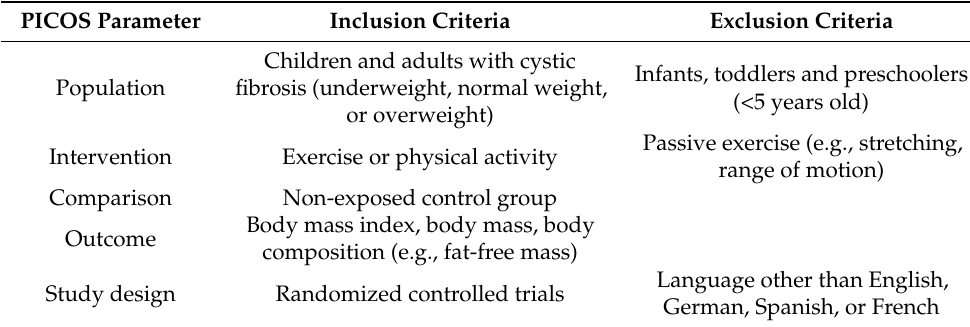
Table 1. Summary of inclusion and exclusion criteria based on population/patient, intervention, comparator, outcome, and study design (PICOS). PICOS Parameter Inclusion Criteria Exclusion Criteria Children and adults with cystic Infants, toddlers and preschoolers Population fibrosis (underweight, normal weight, (<5 years old) or overweight) Passive exercise (e.g., stretching, Intervention Exercise or physical activity range of motion) Comparison Non-exposed control group Body mass index, body mass, body Outcome composition (e.g., fat-free mass) Language other than Study design Randomized controlled trials